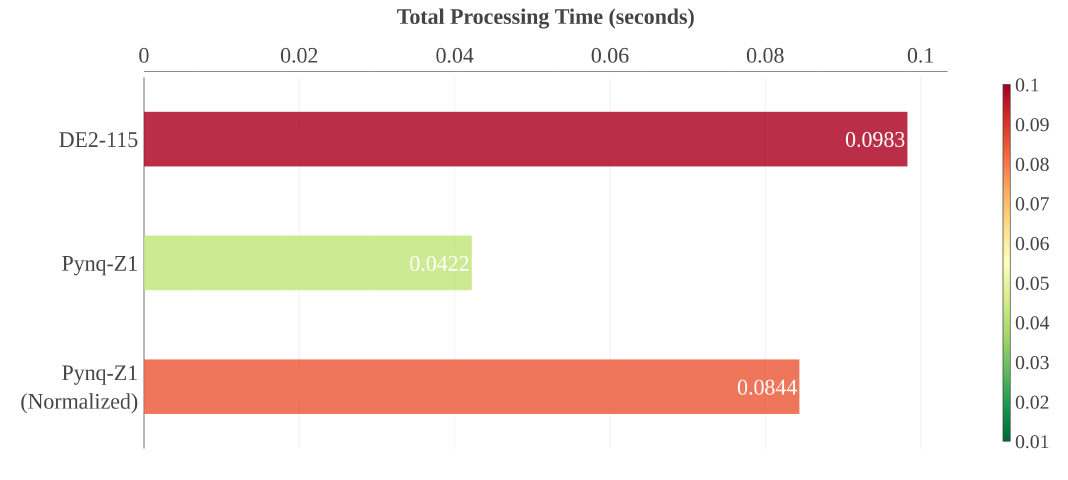
Figure 8. Processing time comparison between the two boards (lower is better). Normalized performance is the theoretical performance with both boards running at the same clock